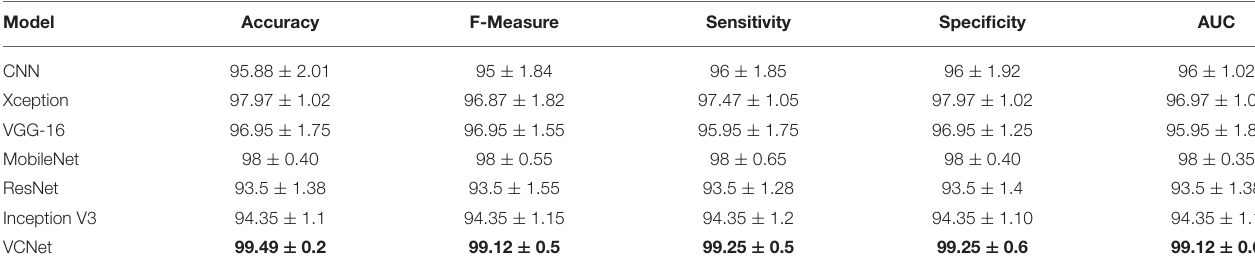
TABLE 4 | Classification matrix of different models using LIDC